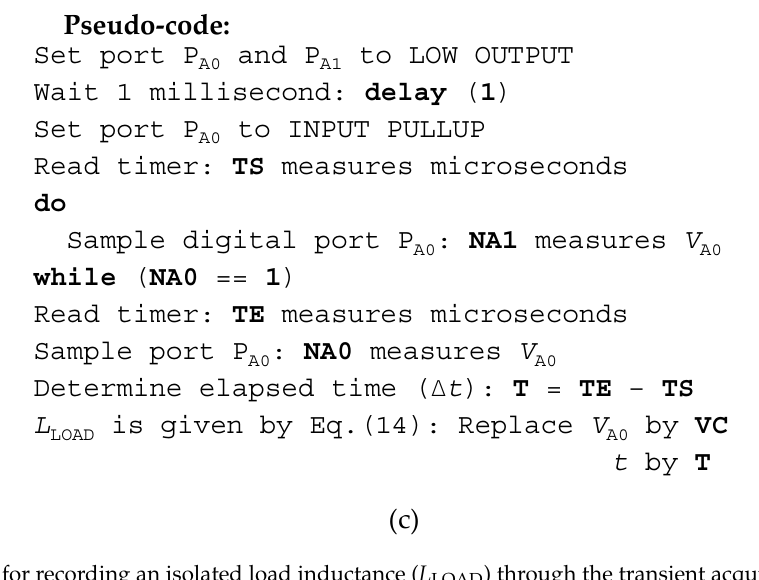
Figure 7. Set-up for recording an isolated load inductance ( L LOAD ) through the transient acquisition mode. ( a ) Impedance representation of the reduced equivalent circuit. ( b ) Illustration of the step response in voltage measured at the input terminal of L LOAD . V IL is defined in Table 1. ( c ) Pseudo- code used to implement the inductance transient acquisition mode.